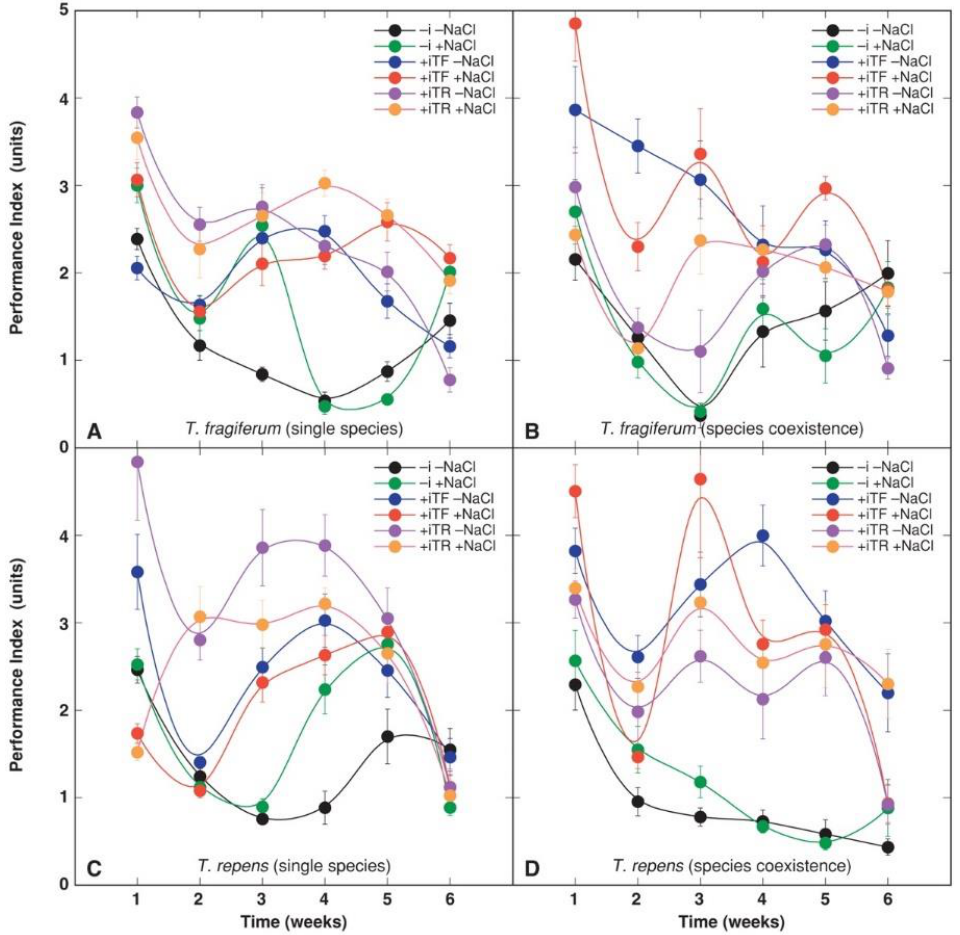
Figure 4. Time course of chlorophyll a fluorescence parameter Performance Index in leaves of T. fragiferum in single species conditions ( A ), T. fragiferum in species coexistence conditions ( B ), T. repens in single species conditions ( C ), T. repens in species coexistence conditions ( D ). Each data point represents the mean from three randomly selected containers per treatment with three measurements per container ± SE. –i, without rhizobial inoculation; +iTF, inoculated with rhizobia from T. fragiferum ; +TR, inoculated with rhizobia from T. repens . Inoculation of T. repens plants with rhizobia had a significant initial stimulative effect on the Performance Index that was more pronounced in the case of inoculants from T. repens (Figure 4C). At this stage, NaCl treatment resulted in a significant decrease in the Performance Index of inoculated plants even below the level found in non-inoculated plants. With increasing substrate salinity, Performance Index values recovered up to the level found in respective treatments without NaCl addition. A positive effect of rhizobial inoculation was significant during the middle part of the experiment, after some pronounced decline of the parameter at week 2. Species coexistence had similar initial effects on the Performance Index of T. repens plants (Figure 4D) similar to those in T. fragiferum in species coexistence conditions. Plants inoculated with rhizobia from T. fragiferum and treated with NaCl had a higher level of Performance Index in the middle part of the experiment, but these inoculated with rhizobia from T. repens had a lower value, in comparison to conditions without species